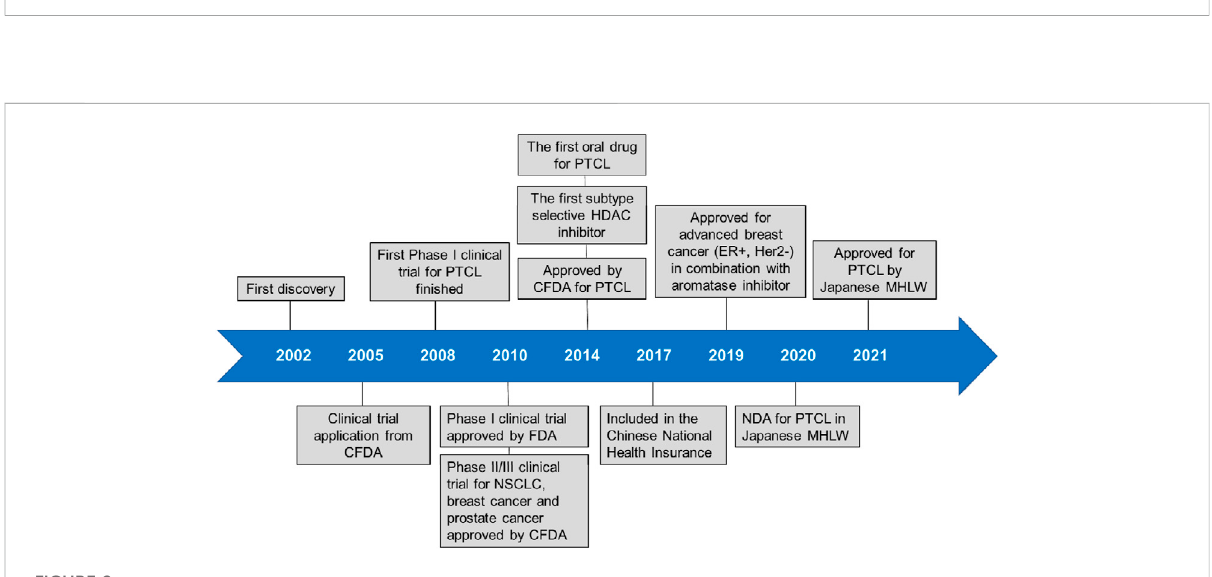
FIGURE 2 Timeline of tucidinostat